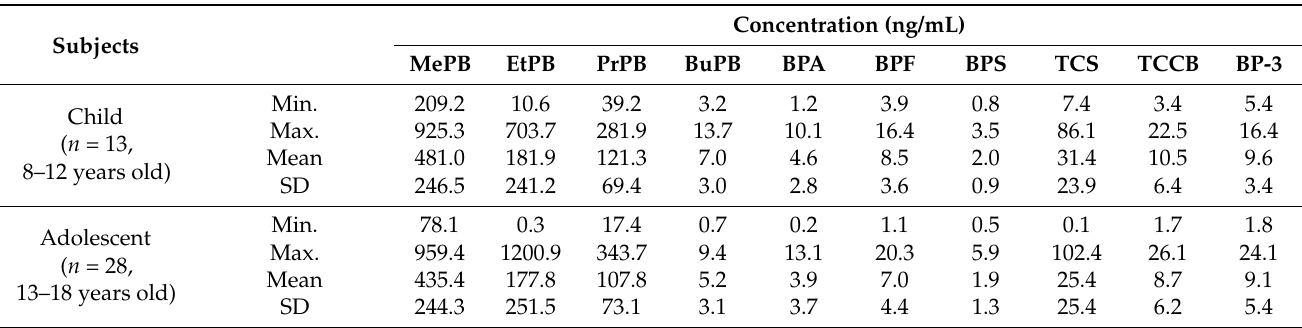
Table 5. Distribution of parabens, bisphenols, triclosan and benzophenone in urine of children and